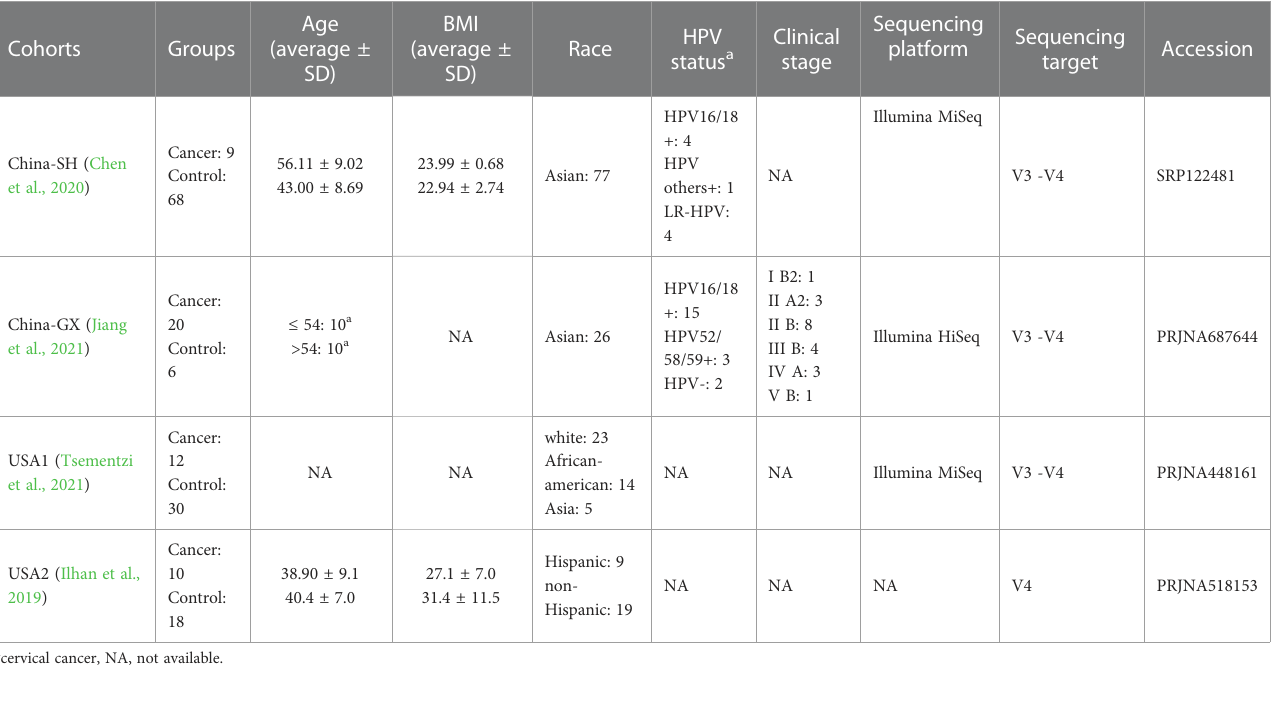
TABLE 1 Characteristics of the 4 datasets included in this